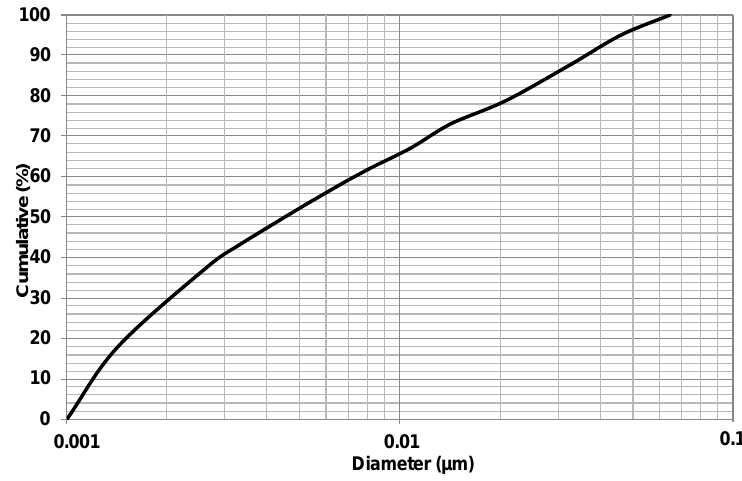
Figure 5. Particle size distribution curve of marble powder.